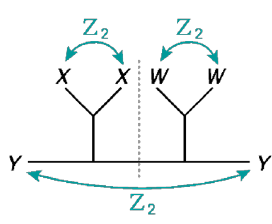
Figure 5 . Permutation symmetries of the comb channel